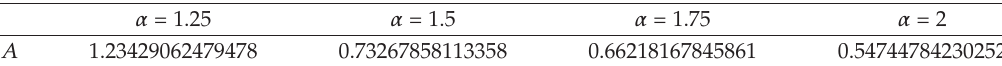
Table 2: Value of A for di ff erent values of α using (cid:7) 7.14 (cid:8)